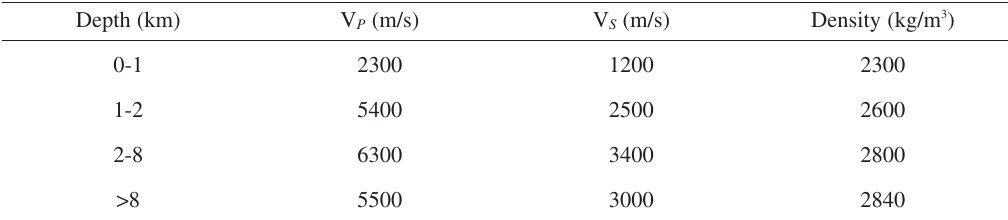
Table I. Multilayered model used in this work (Megna, 2007). Depth (km) V P